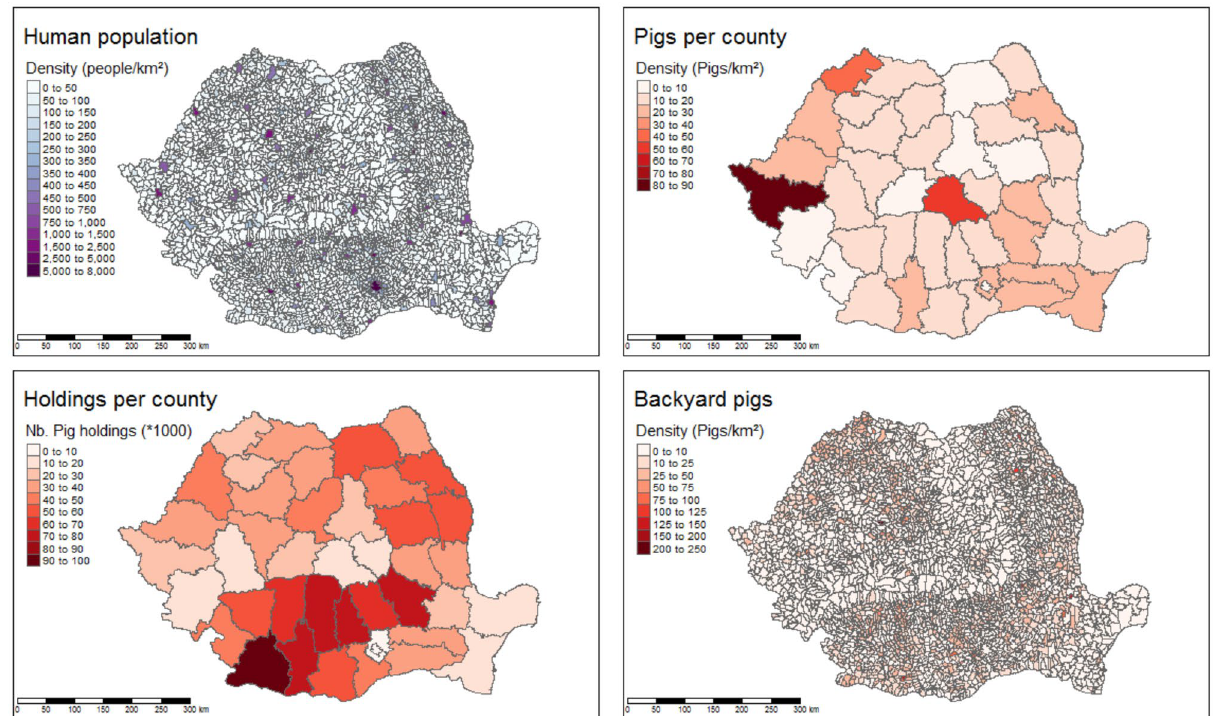
Figure 2. Demographic and agricultural data. Data are presented at the commune level (human population, backyard pigs) or at the county level (pigs, holdings).